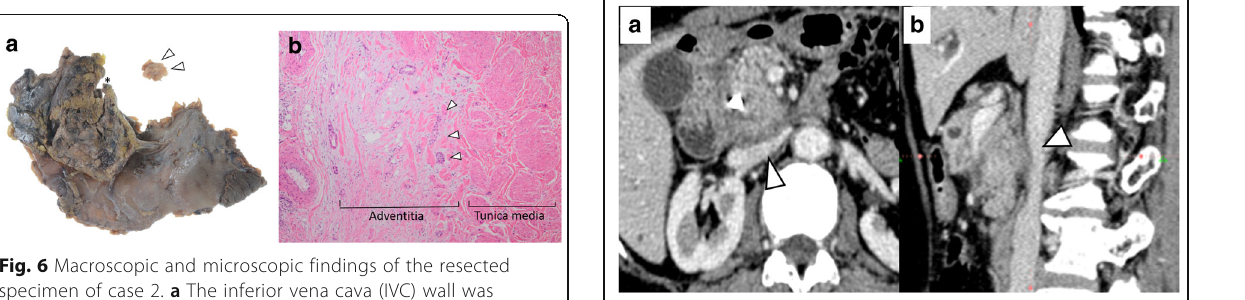
Fig. 8 Preoperative computed tomography (CT) imaging of case 3. a Dense soft tissue connected to the pancreatic lesion widely contacting the ventral surface of the inferior vena cava (IVC) ( arrowhead ). b . Sagittal multi-planar reformation showed that the lesion adhered to and deformed the